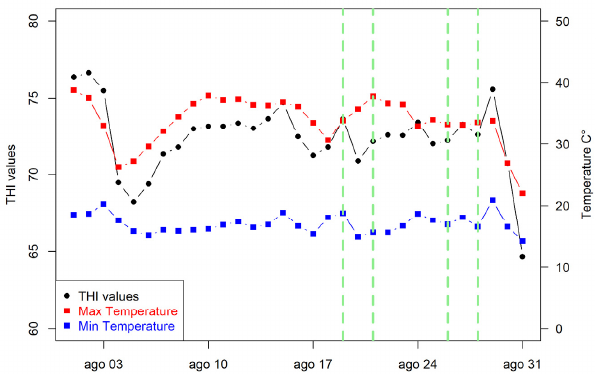
Figure 1. Outdoor minimum, maximum temperatures and temperature humidity index (THI) values recorded throughout August 2020. The study periods are within the green dotted lines. Data of THI within farm and between the ventilation systems were reported as box ‐ plots in Figure 2 for the two different trial periods.